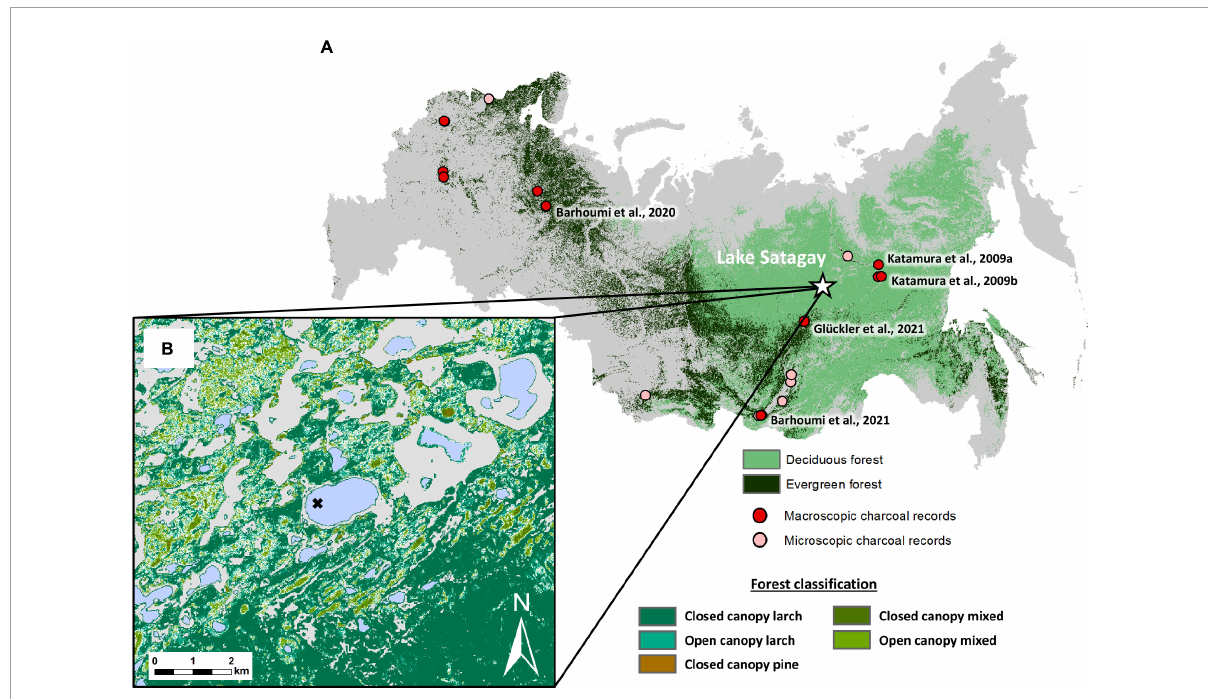
FIGURE1 (A) Location of Lake Satagay [evergreen/deciduous forest classification based on © ESA Climate Change Initiative land cover project, provided via the Centre for Environmental Data Analysis (CEDA)]. Red dots mark available sedimentary charcoal data from previous studies (extracted from the Global Paleofire Database and including only sites where data were provided, last access: 15 January 2022; Power et al., 2010). (B) Lake Satagay and its surrounding vegetation, based on land cover classification from Sentinel 2 acquisitions with ground truthing from expedition observations [Kruse et al., 2021; van Geffen et al., 2021 (Preprint); Geng et al.,